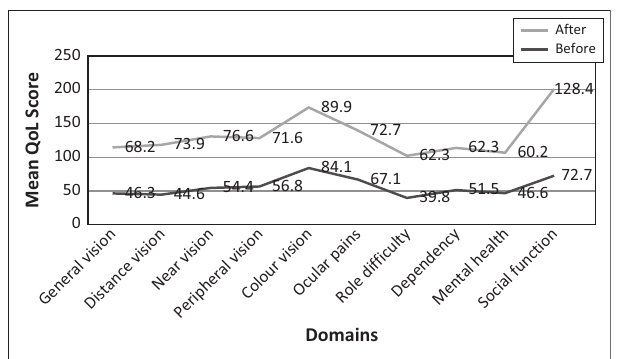
FIGURE 3: Change in quality of life measures after low vision intervention (with optical low vision